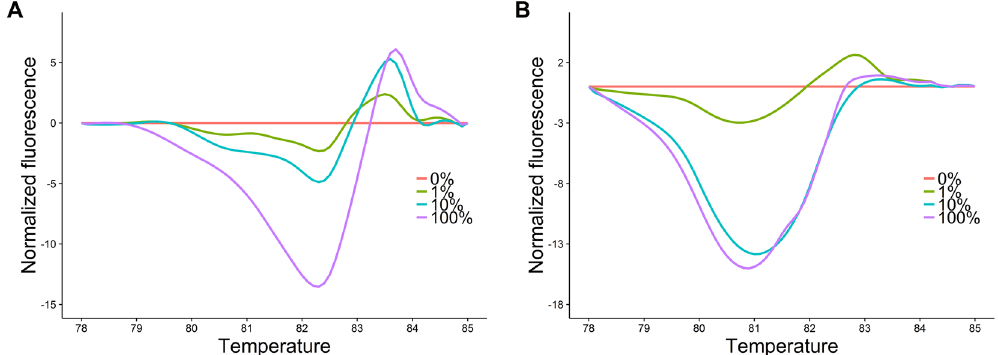
Figure 5. High-resolution melting analysis (HRM) with primers designed to detect mutations in epidermal growth factor receptor (EGFR) exon 19 ( A ) and exon 21 ( B ). DNA mixtures contained mutation rates of 0%, 1%, 10%, and 100%.